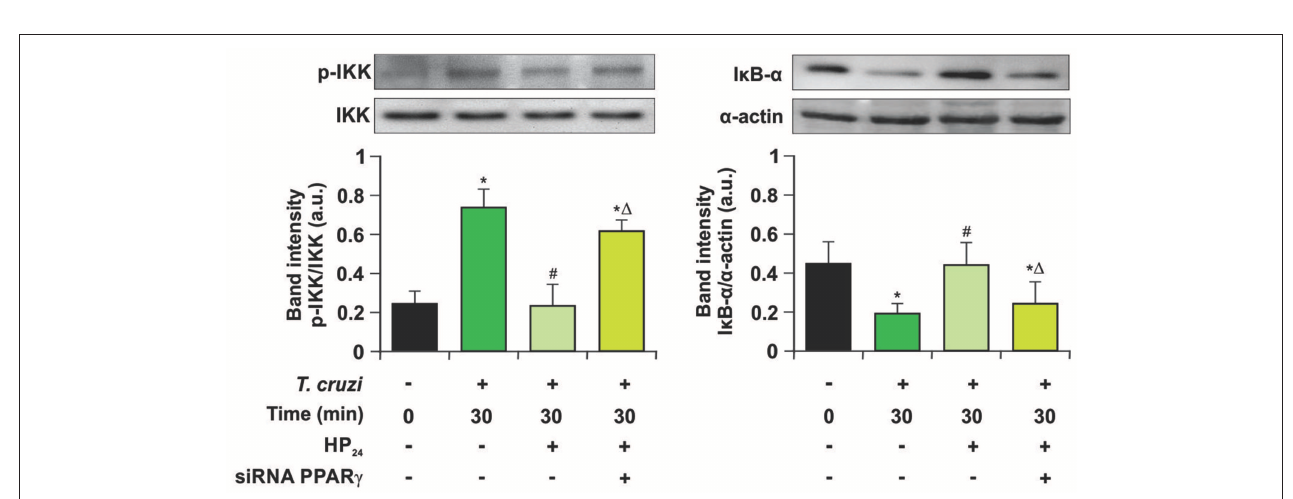
FIGURE 7 | HP 24 inhibits IKK and I κ B- α phosphorylation by PPAR γ -dependent mechanisms. Peritoneal macrophages were obtained and transfected with PPAR γ -siRNA for 72h. Transfected or non-transfected cells were treated with HP 24 (100 µ M) since 30min before infection. Then, these cells were infected for 30min with T. cruzi (parasite:cell ratio 5:1). Cytosolic expression of p-IKK (Ser 180) and I κ B- α was determined by Western blot, and protein levels were normalized against IKK total and α -actin. Results are expressed as mean of three independent experiments * P < 0.05 vs. uninfected cells, # P < 0.05 vs. T. cruzi -infected cells. 1 P < 0.05 vs. T. cruzi -infected HP 24 -treated